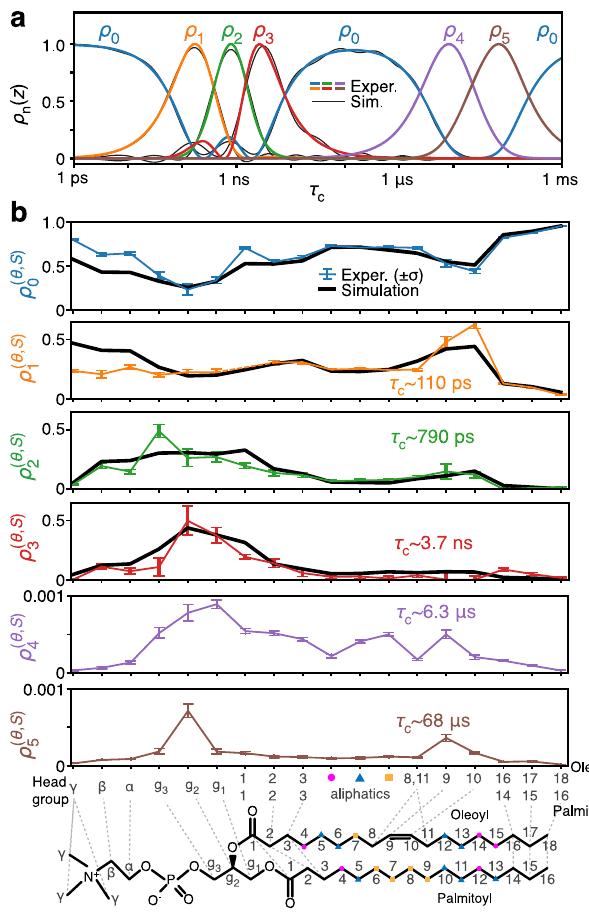
Fig. 1 Experimental vs. MD-derived detector responses. Panel a shows the sensitivity windows for six experimental detectors (color). We use MD data to approximate detectors 0 – 3, where the MD sensitivities are shown in gray. Detectors 4 and 5 are not calculated with MD. For detectors 1 – 5, the widths, Δ z n , in orders of magnitude, are 1.1, 0.8, 1.0, 1.3, and 1.3. In ( b ), the detector responses characterize the amplitude of motion in each window. Colored lines indicate the NMR detector responses and error bars indicate the 68% con fi dence interval, determined via linear propagation of error applied to the error of the experimental rate constants (see Supplementary Note 1, subsection 3 for details on experimental error determination). Black lines indicate the MD-determined amplitude, averaged over 256 copies of POPC in the MD simulation. Where experimental data are not resolved over multiple carbons, we average together the simulated data for the same carbons with uniform weighting for comparison to the experiment. Source data are provided as a Source Data